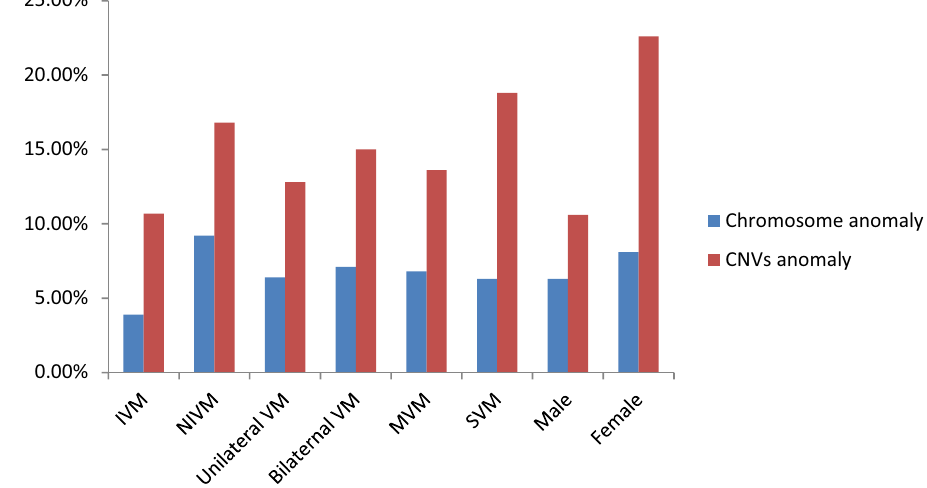
Figure 3. Classification characteristics of 222 fetuses with ventriculomegaly.